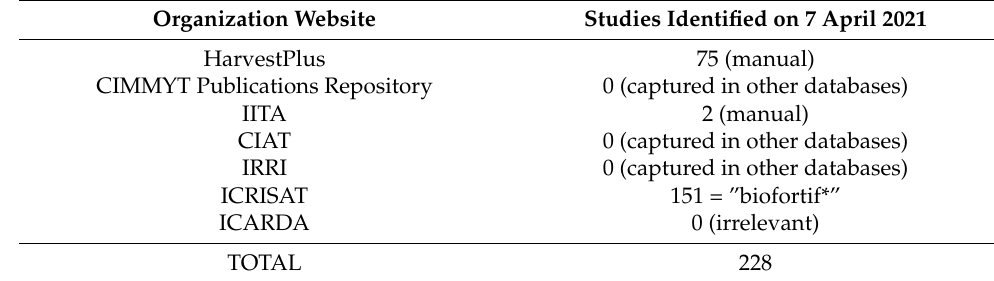
Table 2. Results from hand-searching organization